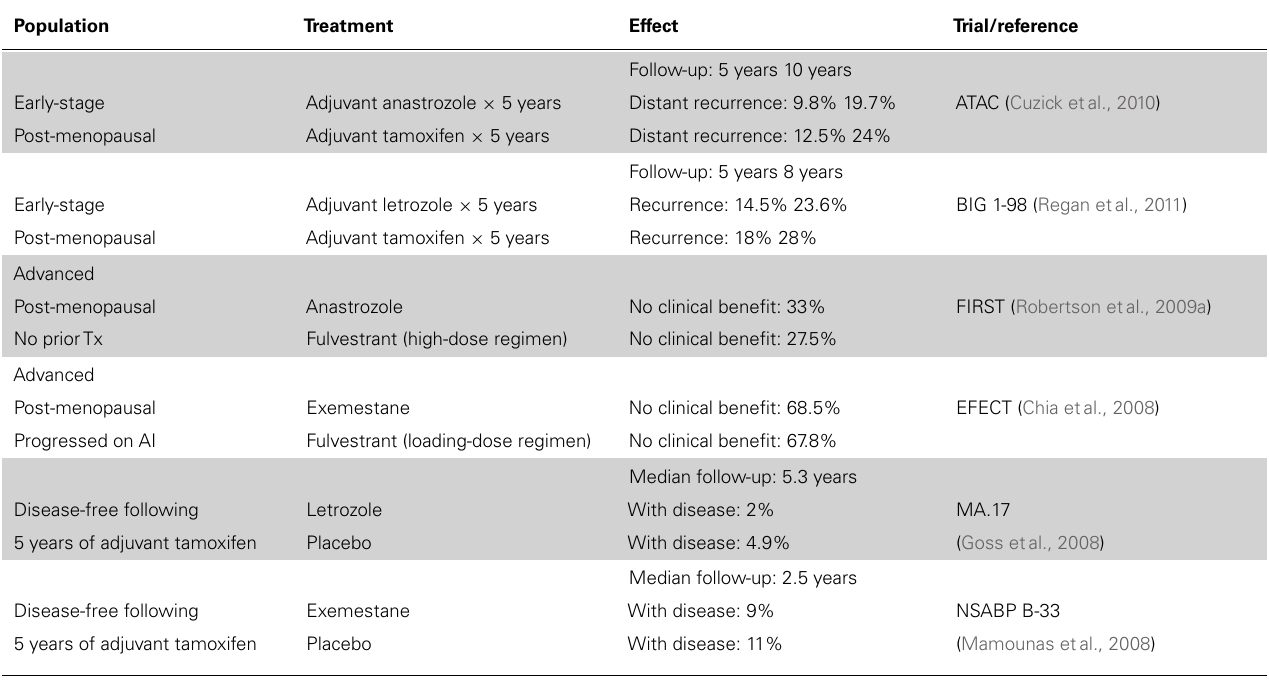
Table 1 | Frequencies of breast cancer recurrence and resistance to anti-estrogen therapies in patients with ER + breast cancer.